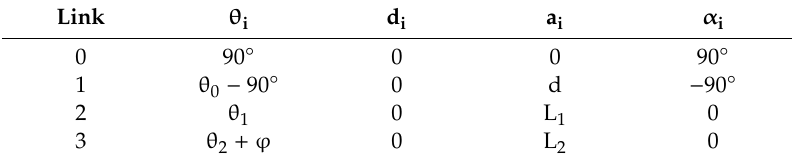
Table 1. Denavit–Hartenberg (D-H) parameters for the 3DOF (3 degrees of freedom) leg. Link θ i d i a i α i 0 90 ◦ 0